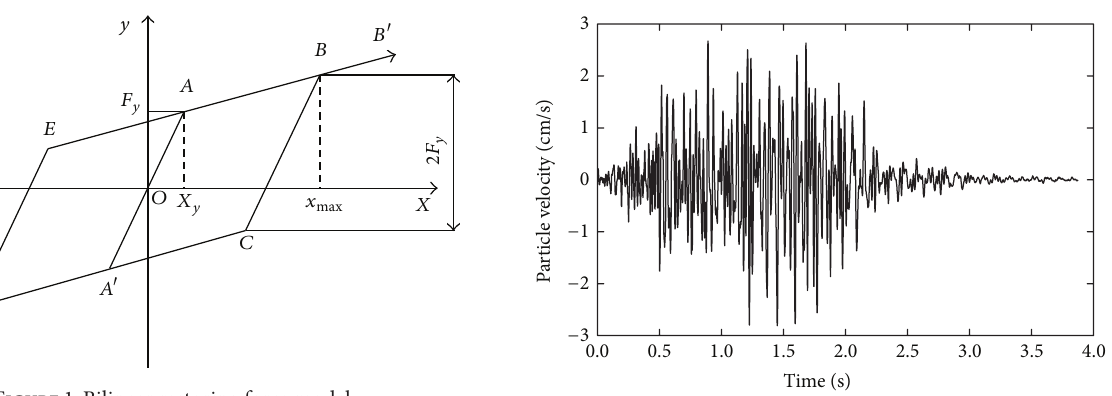
Figure 2: A velocity waveform measured in an open pit induced by a